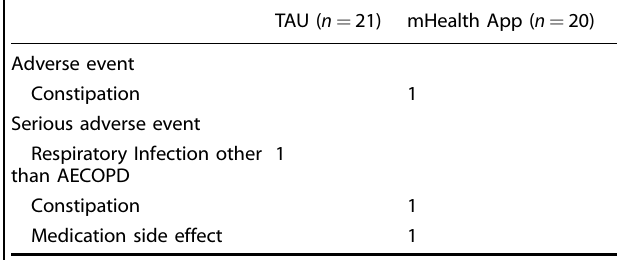
Table 1. Baseline participant characteristics.